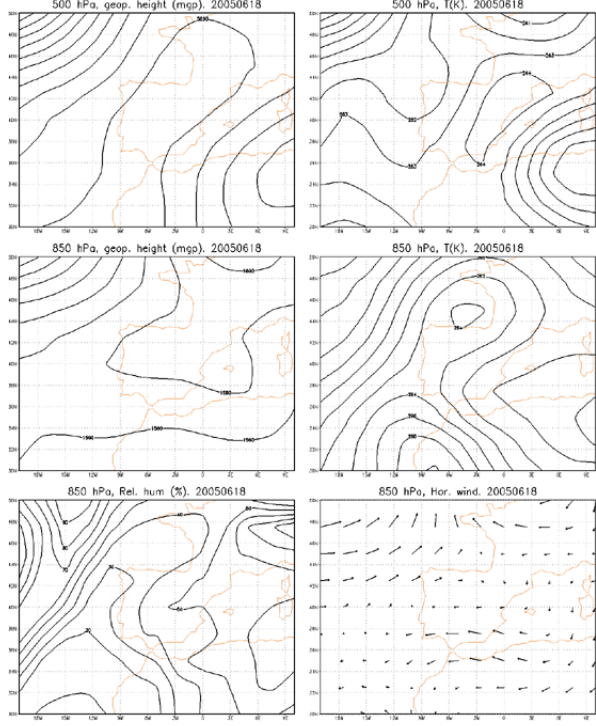
Fig. 12. NCEP reanalysis, 12:00UTC. Date: 18 June 2005, CL4. The atmospheric fields shown are: φ 500 (gpm), T 500 (K), φ 850 (gpm), T 850 (K), rh 850 (%) and wind direction at 850hPa, from left to right.